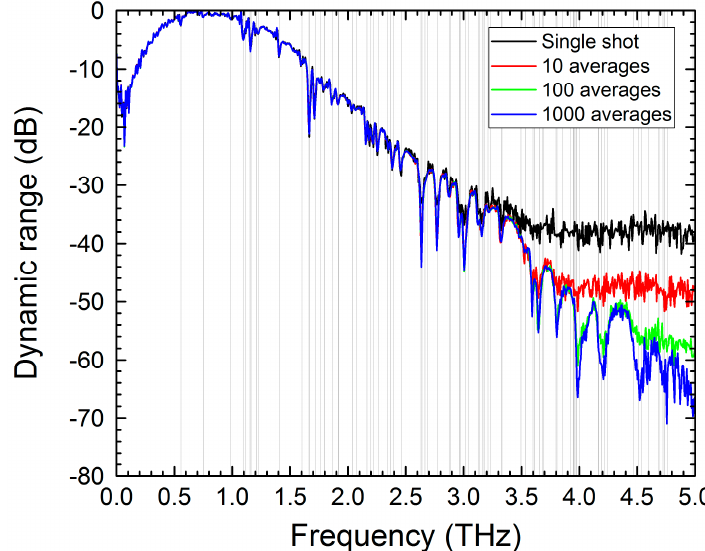
Figure 5. Dynamic-range spectrum of the terahertz power for a single-shot measurement (black trace), and for 10 (red), 100 (green), and 1000 (blue) averages of terahertz pulse traces. Spectra are obtained with the ECOPS system at 1600 traces per second. Vertical grey lines indicate water vapor absorption frequencies according to the HITRAN database [33].